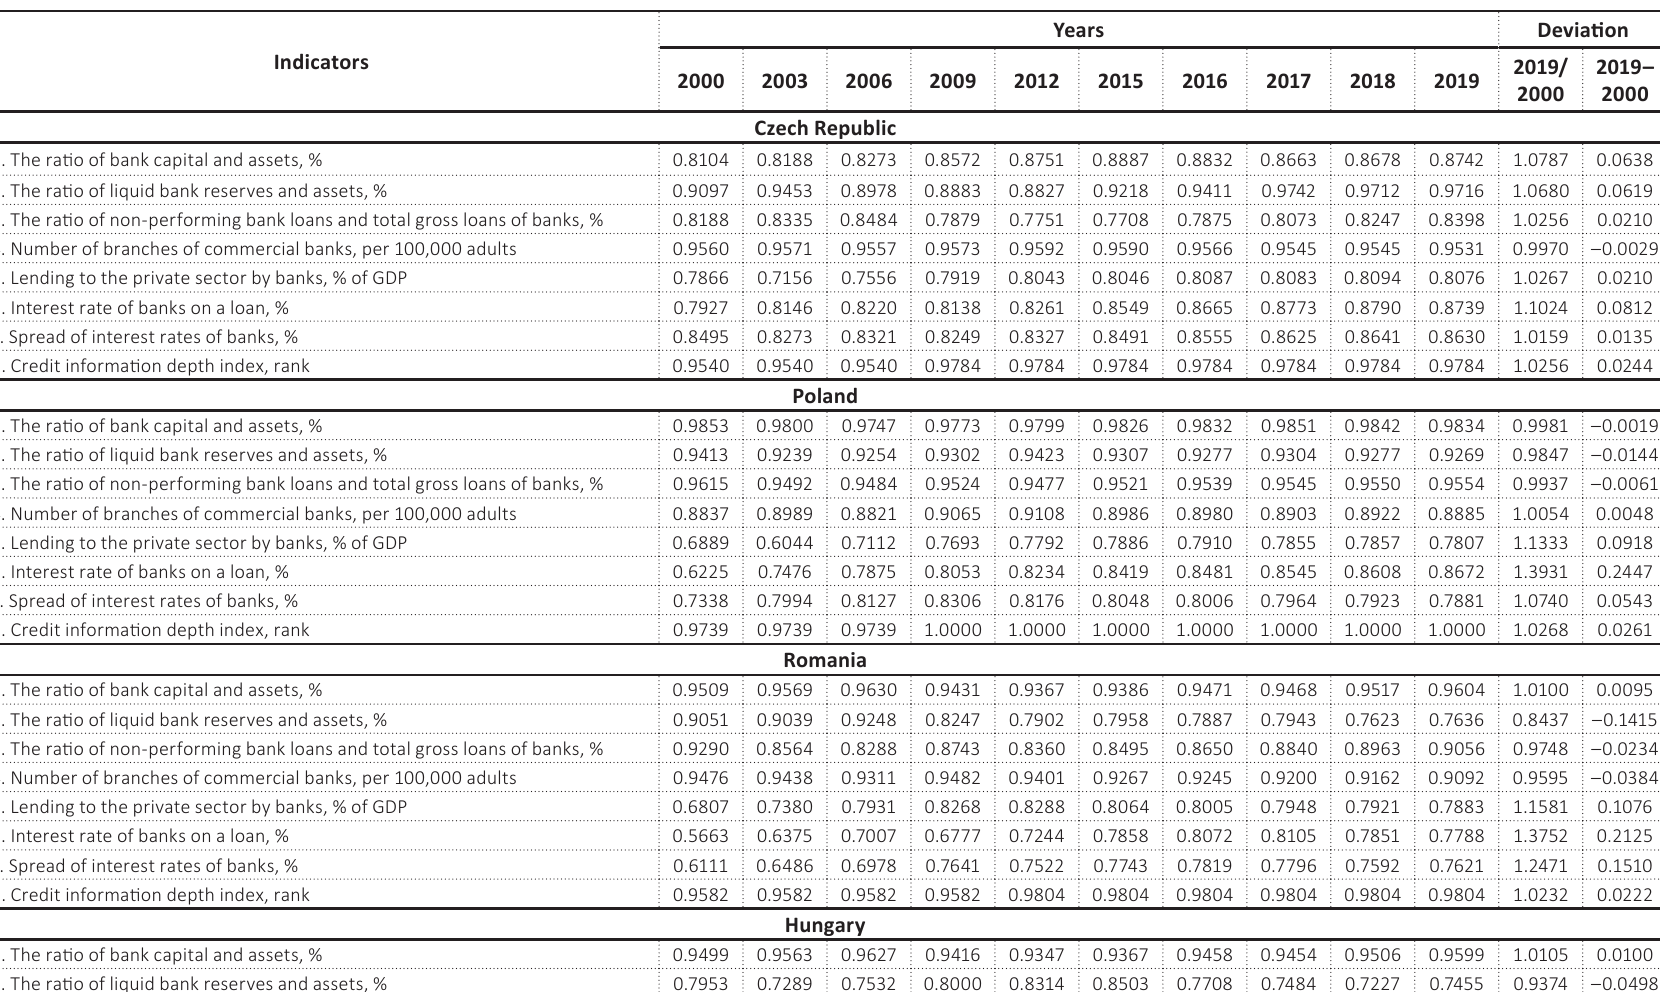
Source: Calculations based on World Bank